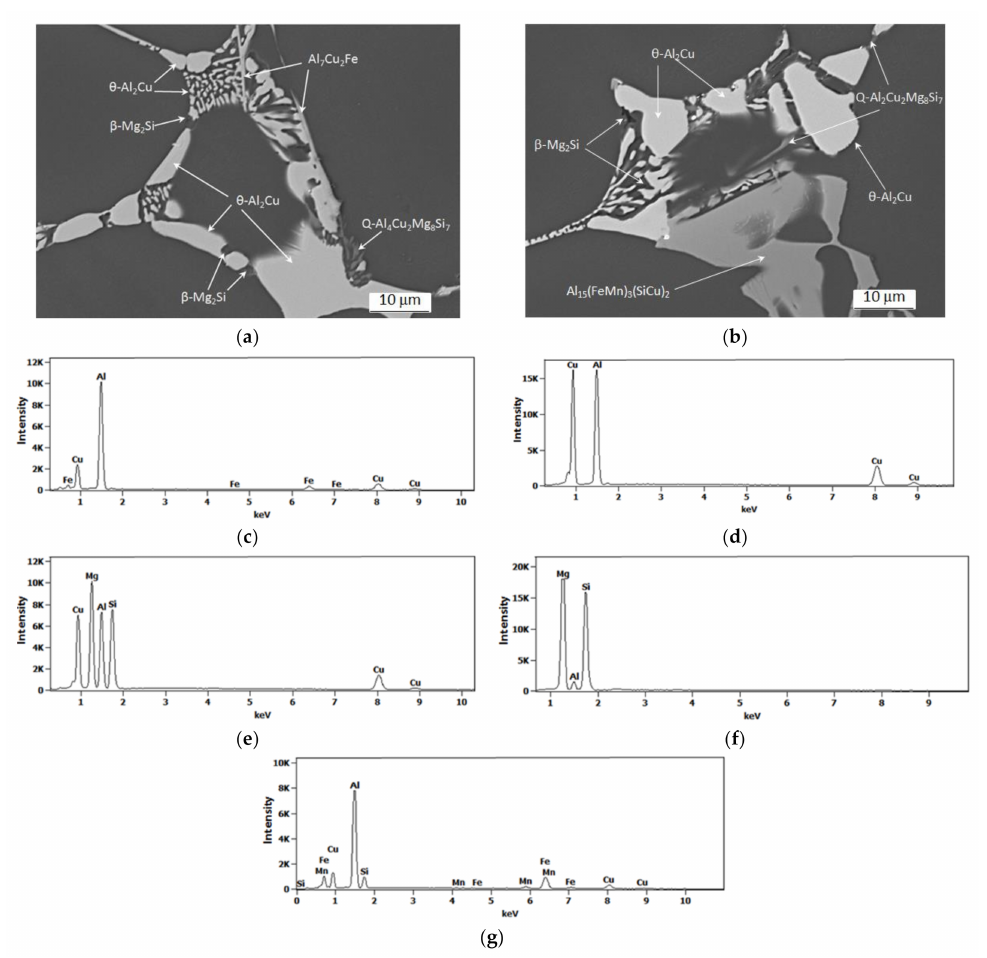
Figure 7. SEM microstructure of the 2017A alloy obtained from recycling after casting ( a , b ) and typical EDS spectra of the analyzed particles: ( c ) Al 7 Cu 2 Fe phase, ( d ) θ -Al 2 Cu phase, ( e ) Q-Al 4 Cu 2 Mg 8 Si 7 phase, ( f ) β -Mg 2 Si phase and ( g ) α -Al 15 (FeMn) 3 (SiCu) 2 phase.